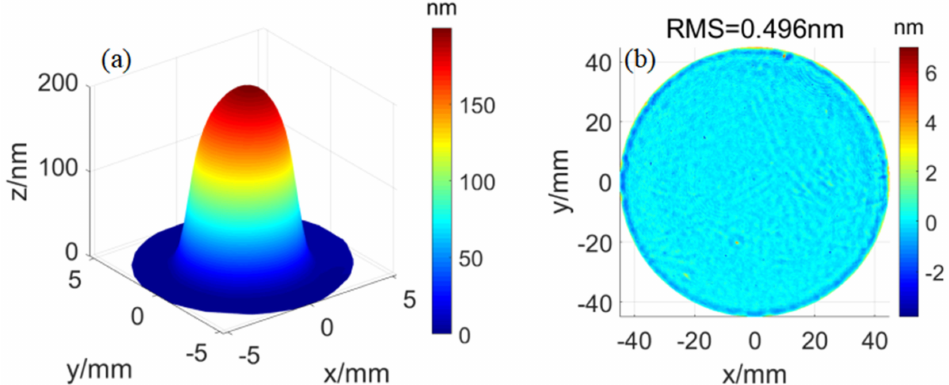
Figure 17. Conditions and results of the simulation: ( a ) the removal function of the beam with 10 mm diameter, and ( b ) the residual error.